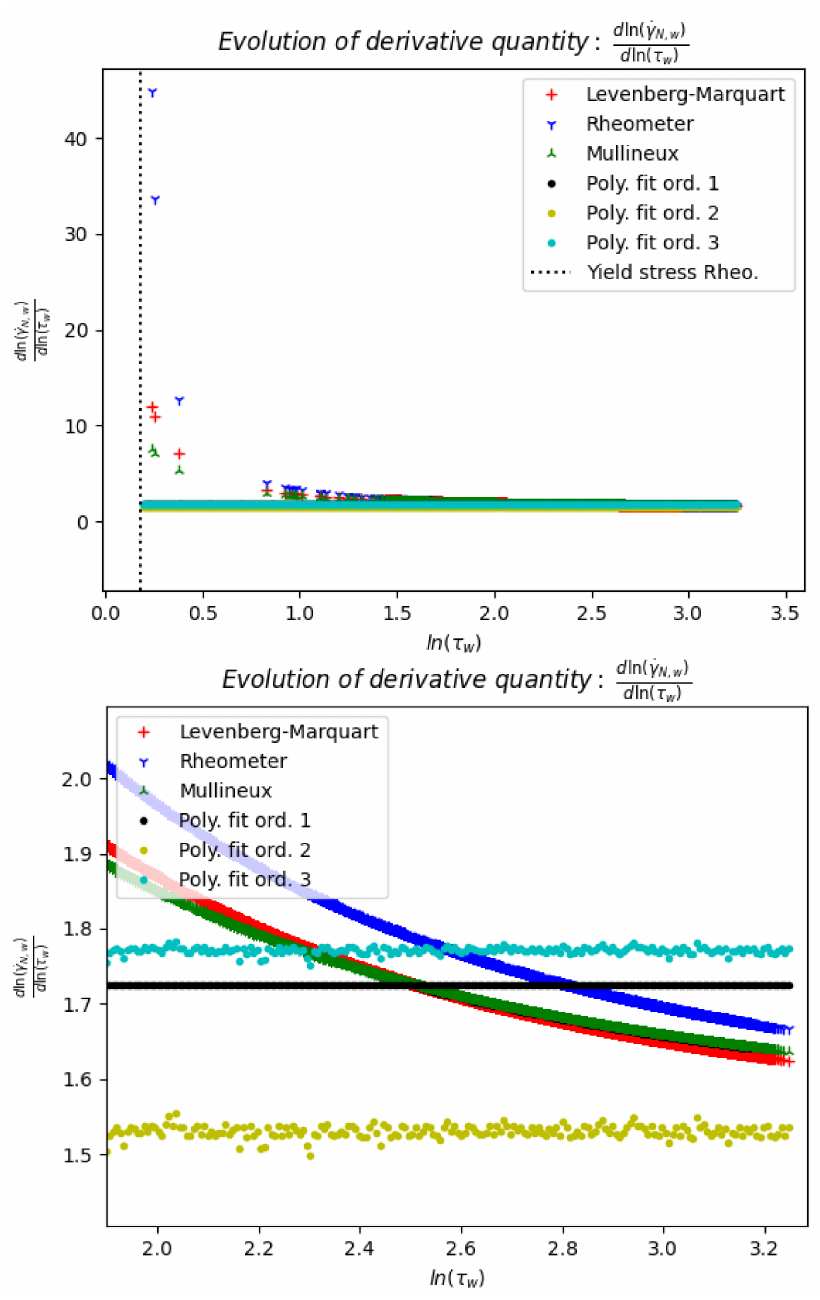
d ln ( . γ N , w ) Figure 7. Estimation of using Equation (12) and the method corresponding to the legend d ln ( τ w ) ln ( . γ N , w ) for the first three curves and using a polynomial fit of in the order mentioned in the legend. ln ( τ w ) . γ N , w is expressed in reciprocal seconds and τ w in